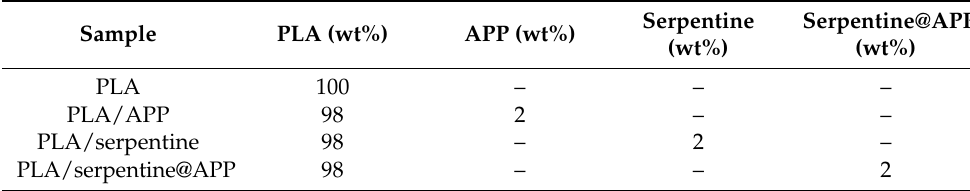
Table 1. Formulations of pure PLA and its